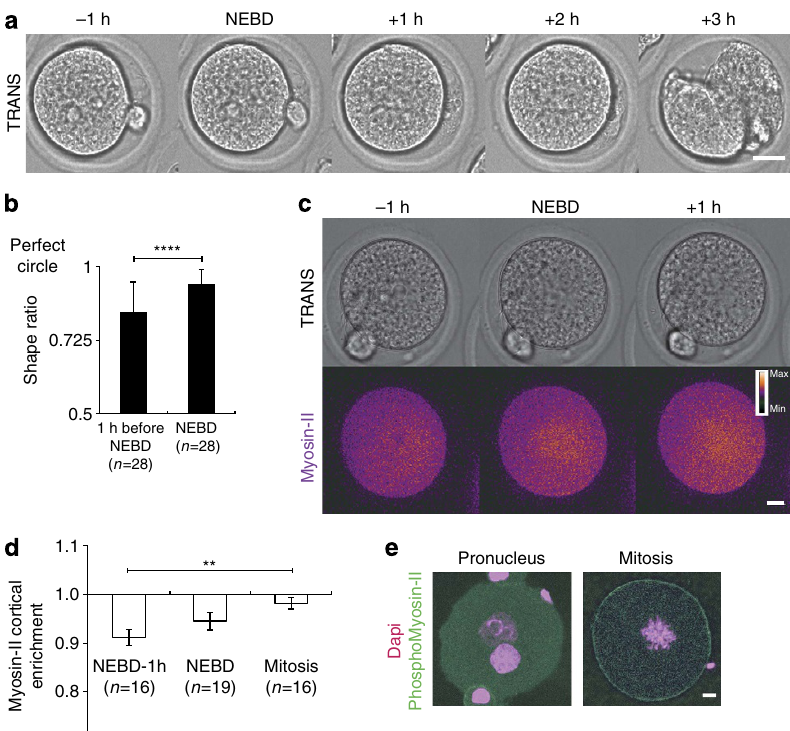
Figure 5 | Embryos round up at NEBD following a Myosin-II-dependent cortical tension increase. ( a ) Embryo before and during the first mitosis. One Z-plane is shown every 1h. Scale bar, 10 m m. ( b ) Graph bar showing the shape ratio (see Methods) of embryos before and during mitosis. Mean is shown of 28 embryos from 10 independent experiments. s.d. is plotted on each bar. Statistical significance of differences is assessed with a Mann–Whitney test ( P value o 0.0001). ( c ) Embryo observed by transmitted light (upper panel) expressing SF9–GFP (Myosin-II intrabody, blue: lower intensity, orange: higher intensity). One Z-plane is shown every 1h. Scale bar, 10 m m. ( d ) Bar graph showing the ratio between the average intensities of cortical versus cytoplasmic Myosin-II in embryos expressing SF9–GFP 1h before NEBD, at NEBD or during mitosis. For each embryo, six measurements were taken in the cortex and six in the cytoplasm (see Methods). Mean of 16 embryos 1h before NEBD, 19 at NEBD and 16 mitotic embryos is shown assessed over 6 independent experiments. S.e.m. is plotted on each bar. Statistical significance of differences is assessed with a t -test ( P values: 1h before NEBD/NEBD 0.1854; NEBD/mitotic 0.1066; 1h before NEBD/mitotic 0.0013). ( e ) Control embryo at the Pronucleus stage (left panel) or during mitosis (right panel) stained for chromosomes (magenta, Z-projection is shown over 25 m m) and PhosphoMyosin-II (green, one Z-plane is shown). Scale bar, 5 m m.